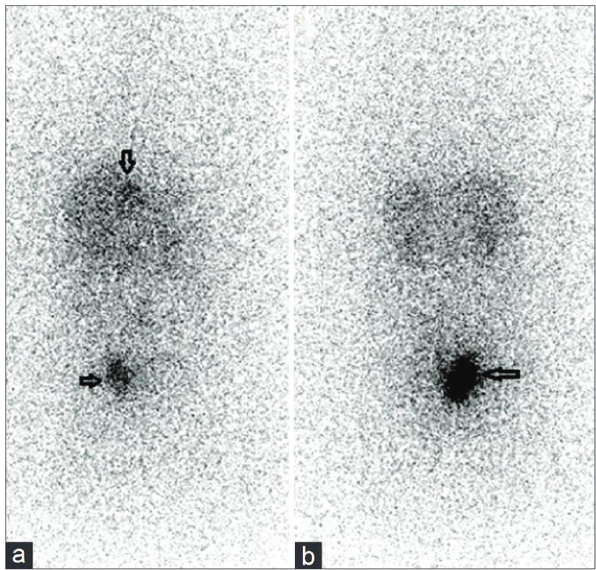
Figure 4. Anterior ( a ) and posterior ( b ) post-therapy whole-body SPECT/CT scans showing intense accumulation in pararectal lesion (horizontal arrows) and liver metastases (vertical arrows) in a patient with a grade 2 NET, 24 h after treatment with 5.5 MBq [ 225 Ac]Ac–DOTATATE, acquired for 30 min using 256 × 1024 matrix and high-energy general-purpose collimators (218 keV and 440 keV photon energies with 20% window width), showing increased uptake in pararectal lesions, lymph nodes, and liver metastases [82].